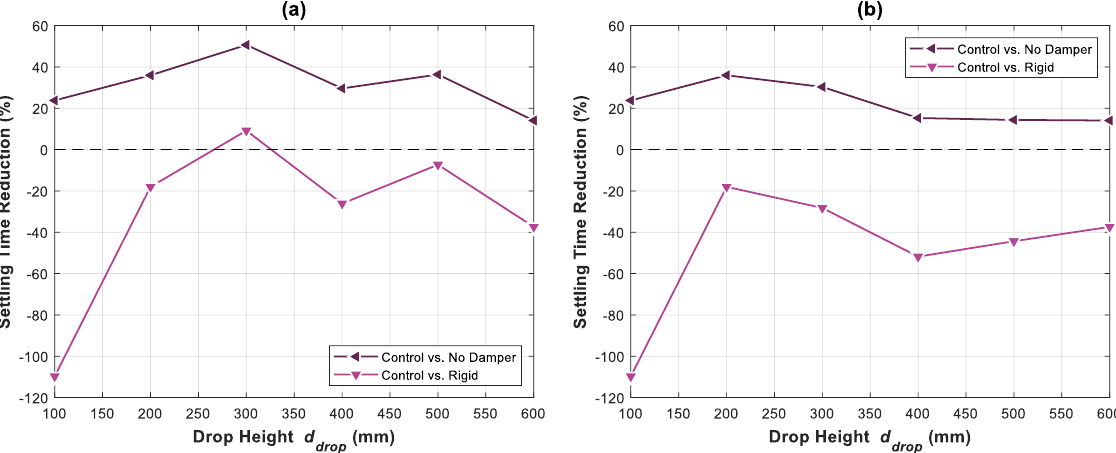
Figure 14. Controller improvement in settling time for impact tests with total masses of ( a ) 2.65 kg and ( b ) 4.60 kg.